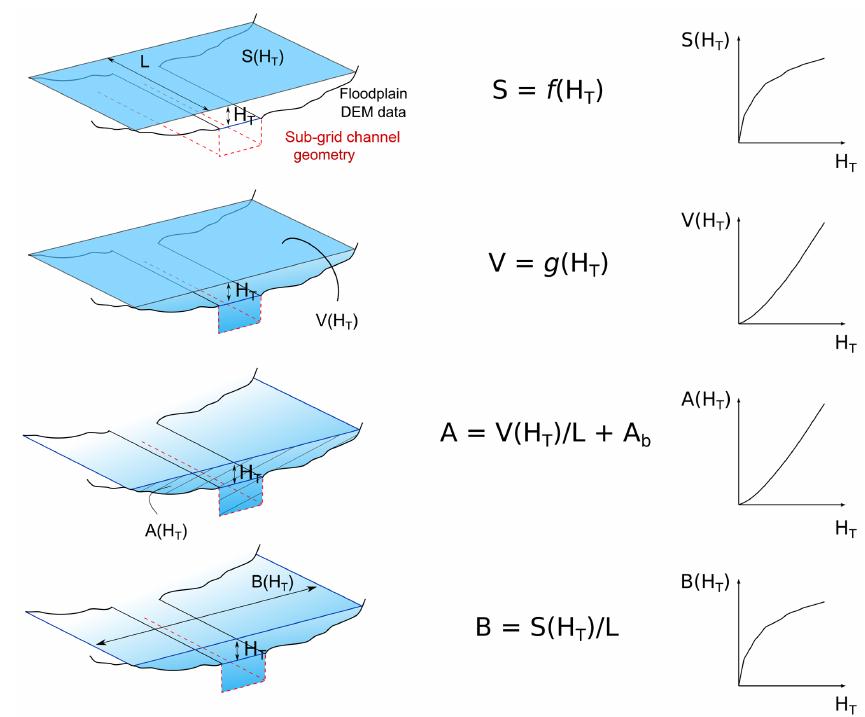
Figure 4. Representation of the reach-scale geometry derived from HAND and the DEM. A(H T ) and B(H T ) are derived from V (H T ) and S(H T ) respectively (Eqs. 1 and